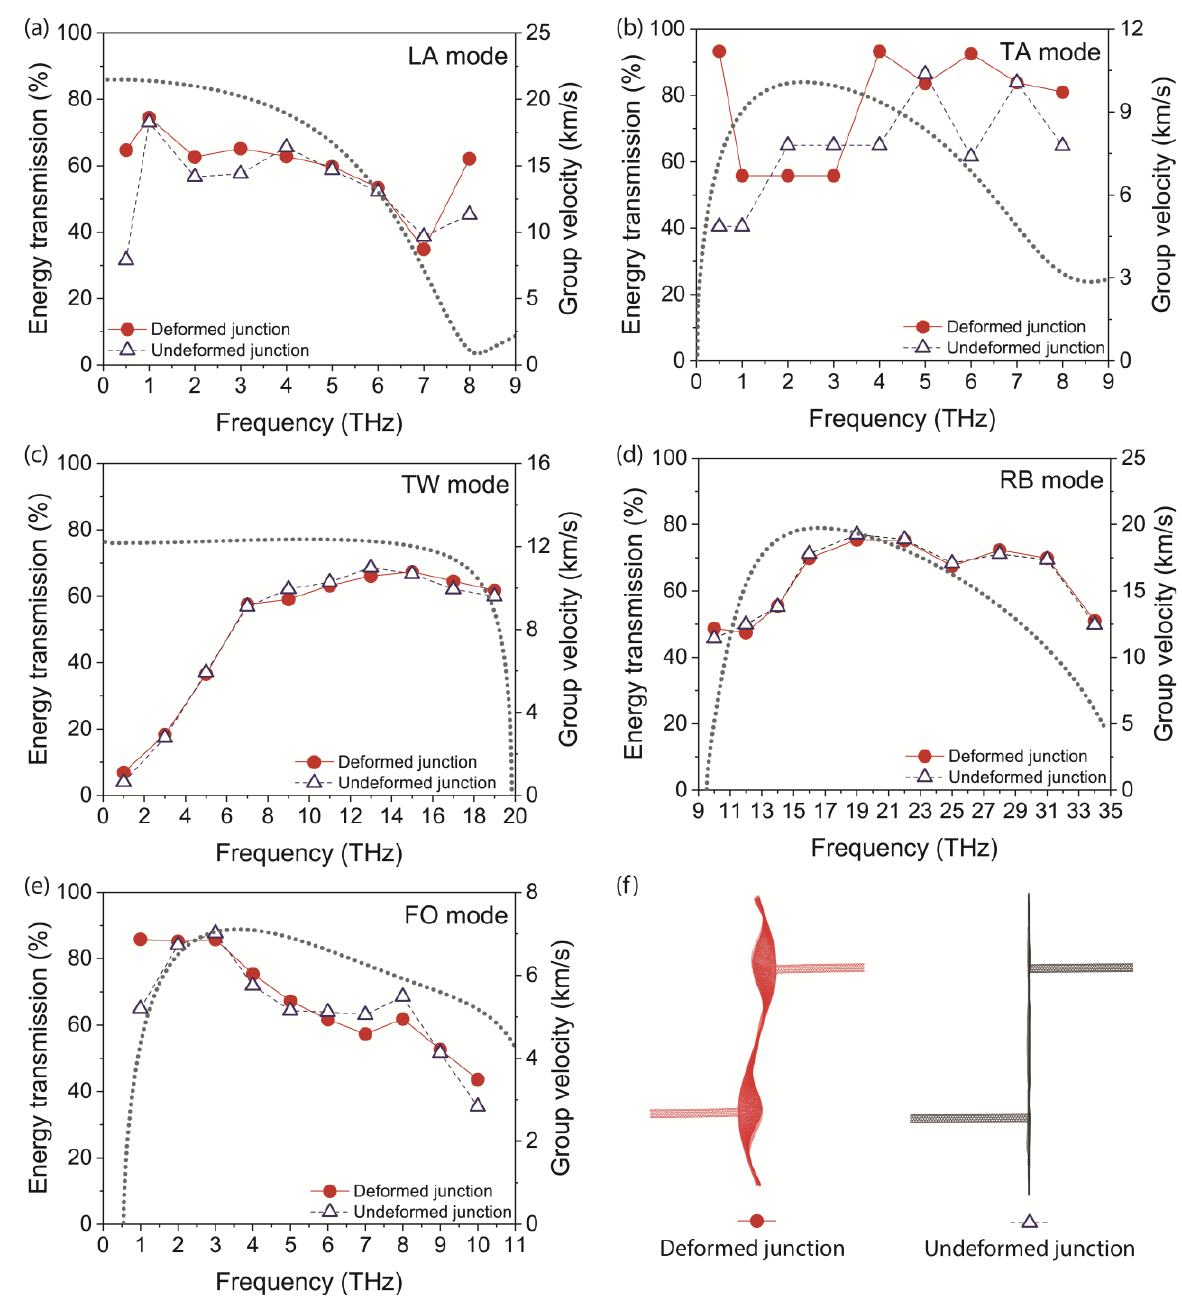
Figure 4. Percent energy transmission through a SWCNT – graphene junction in deformed/undeformed junction structures. Group velocity (dotted dark gray line) is also plotted together. ( a ) LA phonon mode. ( b ) TA phonon mode. ( c ) TW phonon mode. ( d ) RB phonon mode. ( e ) FO phonon mode. ( f ) Illustration of deformed and undeformed junctions.